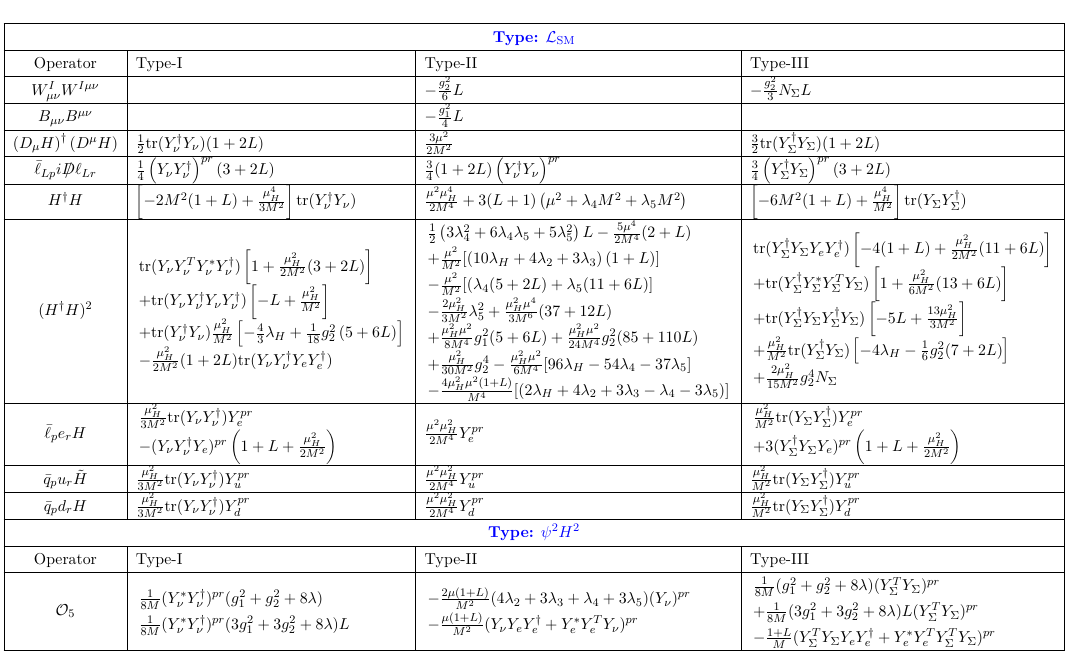
Table 7 . Modifications to L SM and the Weinberg operator from one-loop matching in the Warsaw basis. Fields are not renormalized for simplicity and corrections to the kinetic terms are